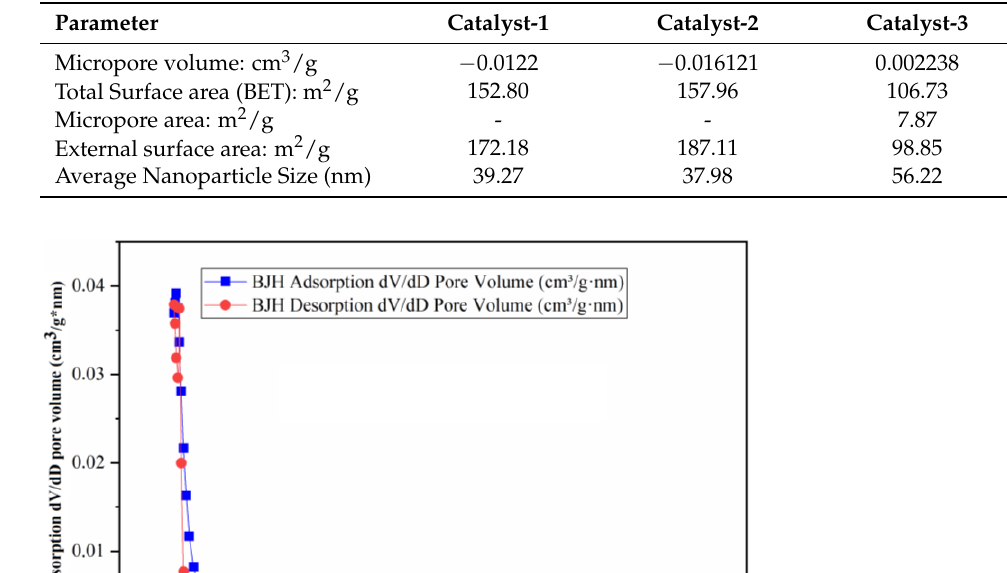
Figure 7. BJH Adsorption and desorption of the pore volume of catalyst - 3. 3. Methods and Materials 3.1. Materials The heavy crude oil sample was received from Tatneft Oil Company (Kazan, Russia), from a heavy oil deposit from Tatarstan, Russia. The properties and composition of the heavy crude oil are shown in Table 3. The heavy oil has a high sulfur content of approximately 4.21%. The solvents n - heptane (99.6%), toluene (98.5%), and isopropyl alcohol (98.8%) were provided by Eco.1 Company (Tathim - product, Kazan, Russia) for SARA analysis, according to ASTM D - 4124. The provided chloroform by Eco.1 was also used as a solvent to collect liquid and solid products after the upgrading processes. Table 3. Properties, chemical composition, and SARA fractions of heavy crude oil. API Gravity (°)